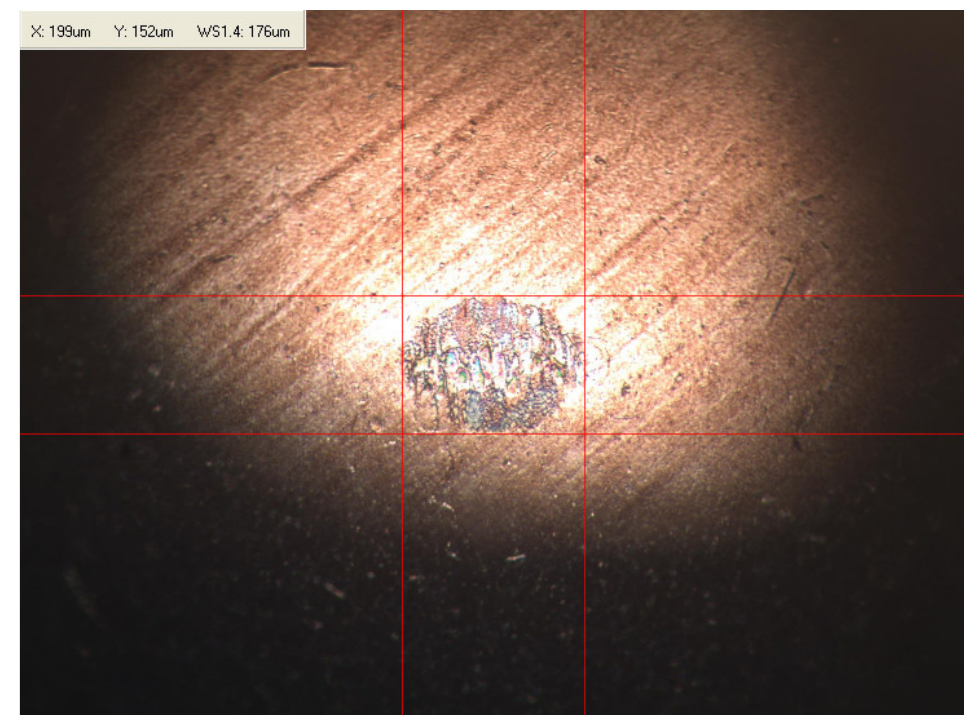
Figure A10. SAE 40—98% m/m; DO—2% m/m.